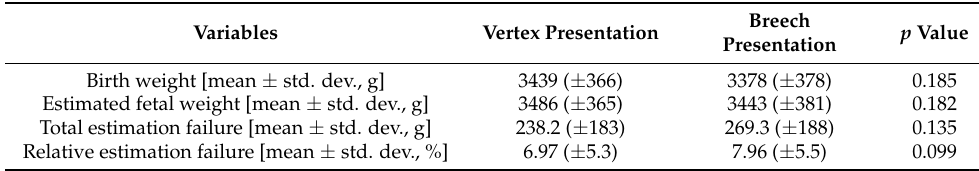
Table 3. Estimated and actual birth weights and estimation failures/differences (calculated with